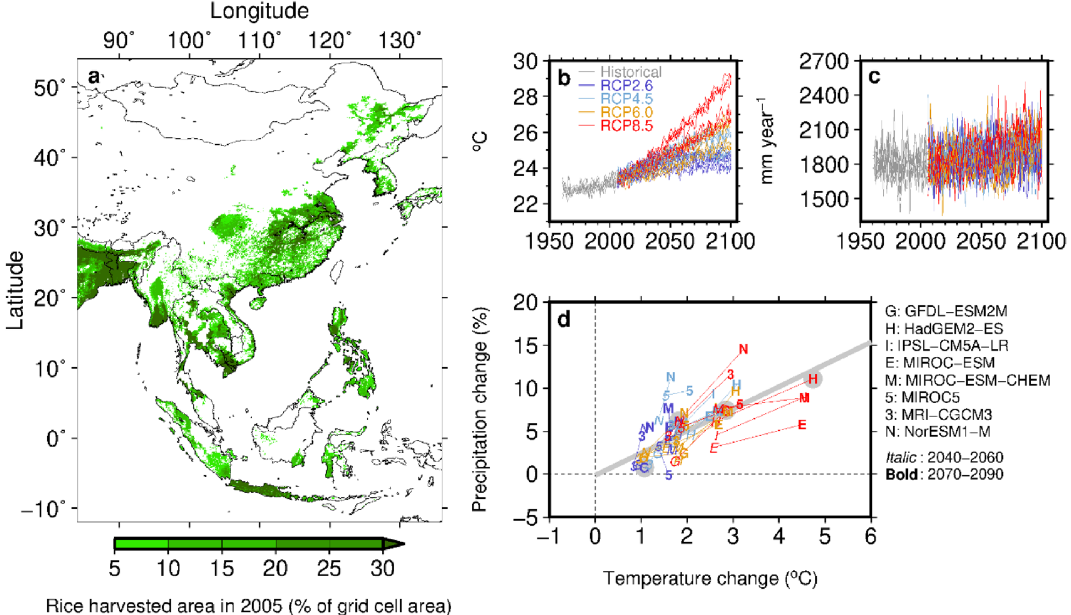
Figure 1. ( a ) The geographic distribution of rice area in 2005. ( b , c ) The projected annual mean temperature and total precipitation over the rice area in Asia (10° S–52° N; 85–135° E) from eight general circulation models (GCMs) under four representative concentration pathways (RCPs). ( d ) The relationship between the projected temperature and precipitation changes for the middle (2041–2060) and end (2081–2100) of the twenty-first century, relative to the period 1986–2005. The gray bold line is the best-fit line. Solid gray circles indicate the four climate scenarios selected for this study, consisting of two RCPs (RCP2.6 and RCP8.5) and two GCMs (GFDL-ESM2M and HadGEM2-ES). The map presented here was created from Generic Mapping Tools (GMT) version 4.5.18 (https:// www. gener ic- mappi ng- tools.